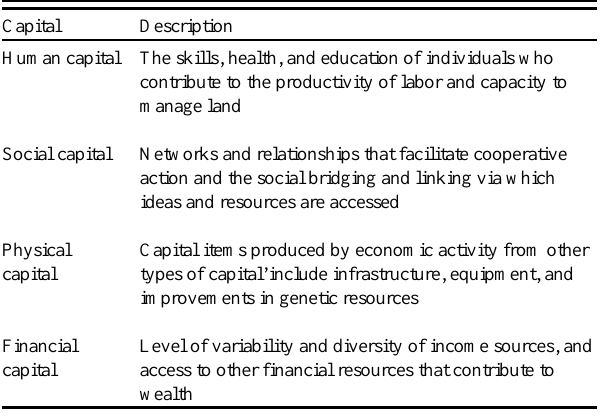
Table 1. The rural livelihoods framework adapted for this